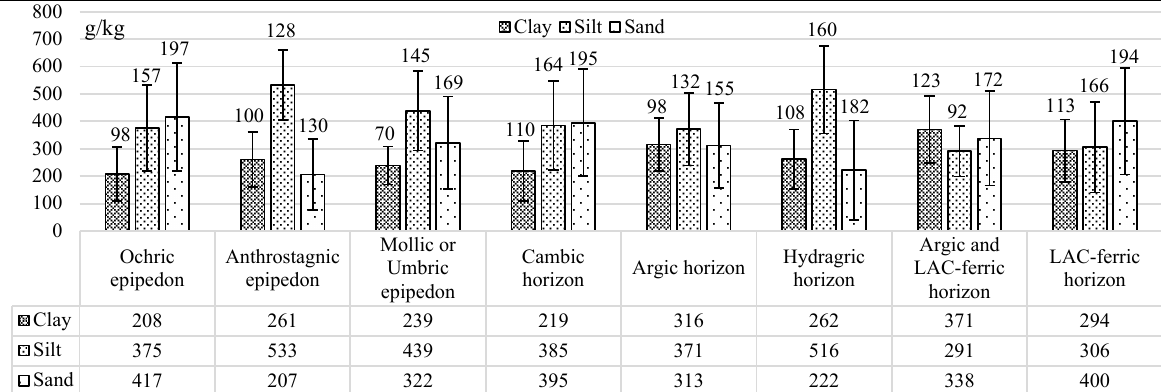
(Figure 3). Soil particle size distribution was measured using the pipette method [25].